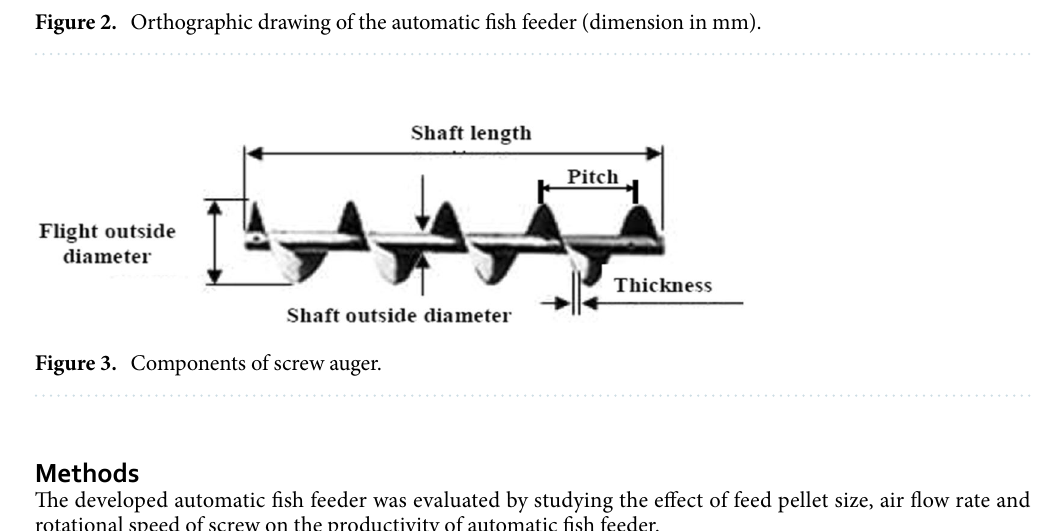
Figure 2. Orthographic drawing of the automatic fish feeder (dimension in mm).